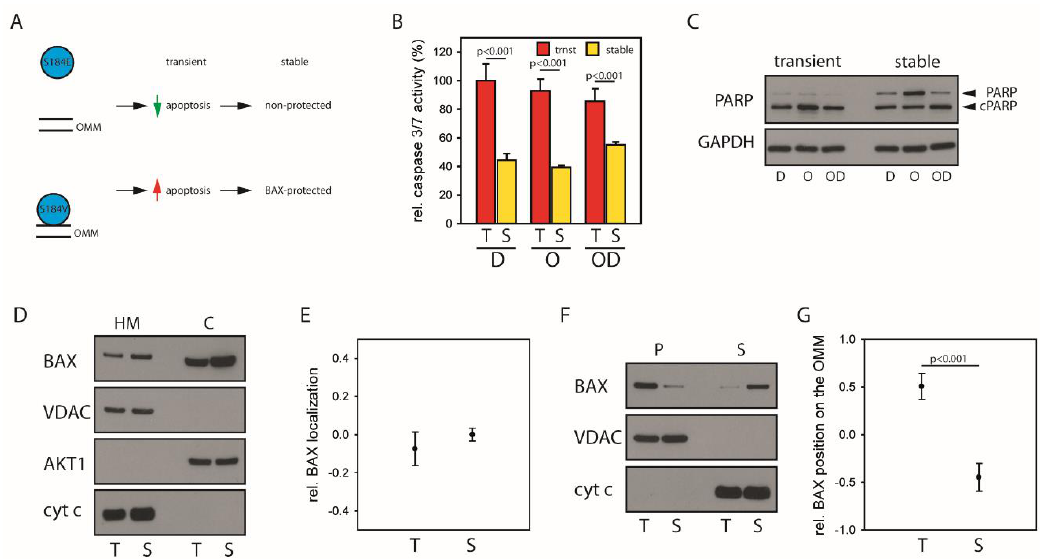
Figure 4. ( A ) Cells were challenged either with mainly cytosolic BAX (S184E, top) or predominantly mitochondrial BAX (S184V, bottom). The experiments were designed to increase the apoptosis predisposition through a large mitochondrial BAX pool, testing the hypothesis that cells challenged with predominantly mitochondrial BAX select for genetic alterations associated with BAX-protected tumors. ( B ) Caspase 3/7 activity induced by 1 µM Daunorubicin (D), 30 µM Olaparib (O) or the combination (OD) for 24 h in HCT116 BAX/BAK DKO cells with either transient (red, trnst, T) or stable (yellow, stable, S) expression of predominantly mitochondrial BAX S184V. Data ± SEM. N = 3 and p -values according to one-way ANOVA using the Holm–Sidak method. Data adjusted to BAX S184V expression. ( C ) Western blot analysis of caspase substrate PARP cleavage in HCT116 BAX/BAK DKO cells with either transient or stable expression of predominantly mitochondrial BAX S184V as in panel ( G ) following treatment with 1 µM Daunorubicin (D), 30 µM Olaparib (O), or the combination (OD). N = 3. ( D ) Subcellular localization of wild type BAX transiently (T, 4 h) or stably (S) expressed in HCT116 BAX/BAK DKO cells after fractionation analyzed by Western blot. Separation of cytosol (C) and heavy membrane fraction (HM, mitochondria) was controlled using AKT1 and VDAC or cyt c, respectively. N = 3. ( E ) Relative wild type BAX localization (log10 scale) after transient (T) and stable (S) expression in HCT116 BAX/BAK DKO cells analyzed by fractionation depicted in D. ( F ) Carbonate extraction (pH 11.5) of wild type BAX transiently (T, 4 h) or stably (S) expressed in HCT116 BAX/BAK DKO cells analyzed by Western blot. Separation of supernatant (S) containing OMM-associated proteins and pellet (P) with OMM-integral proteins was controlled using cyt c (released during the procedure) and VDAC, respectively. N = 3. p -value according to t -test. ( G ) Relative wild type BAX distribution on the OMM between OMM-integral and OMM-associated protein pool determined by carbonate extraction (log10 scale) after transient (T) and stable (S) expression in HCT116 BAX/BAK DKO shown in F.